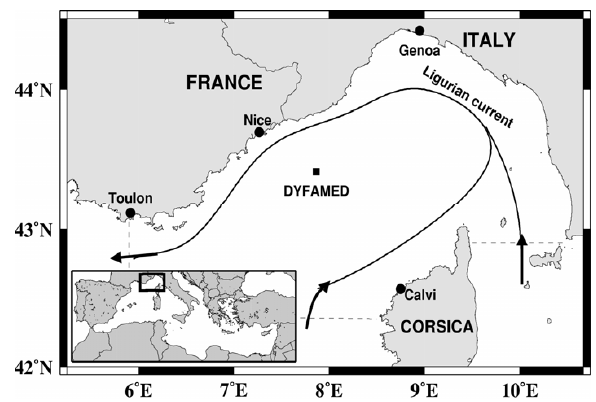
Fig. 1. Location of the DYFAMED time-series station in the Lig- urian Sea, North-western Mediterranean.